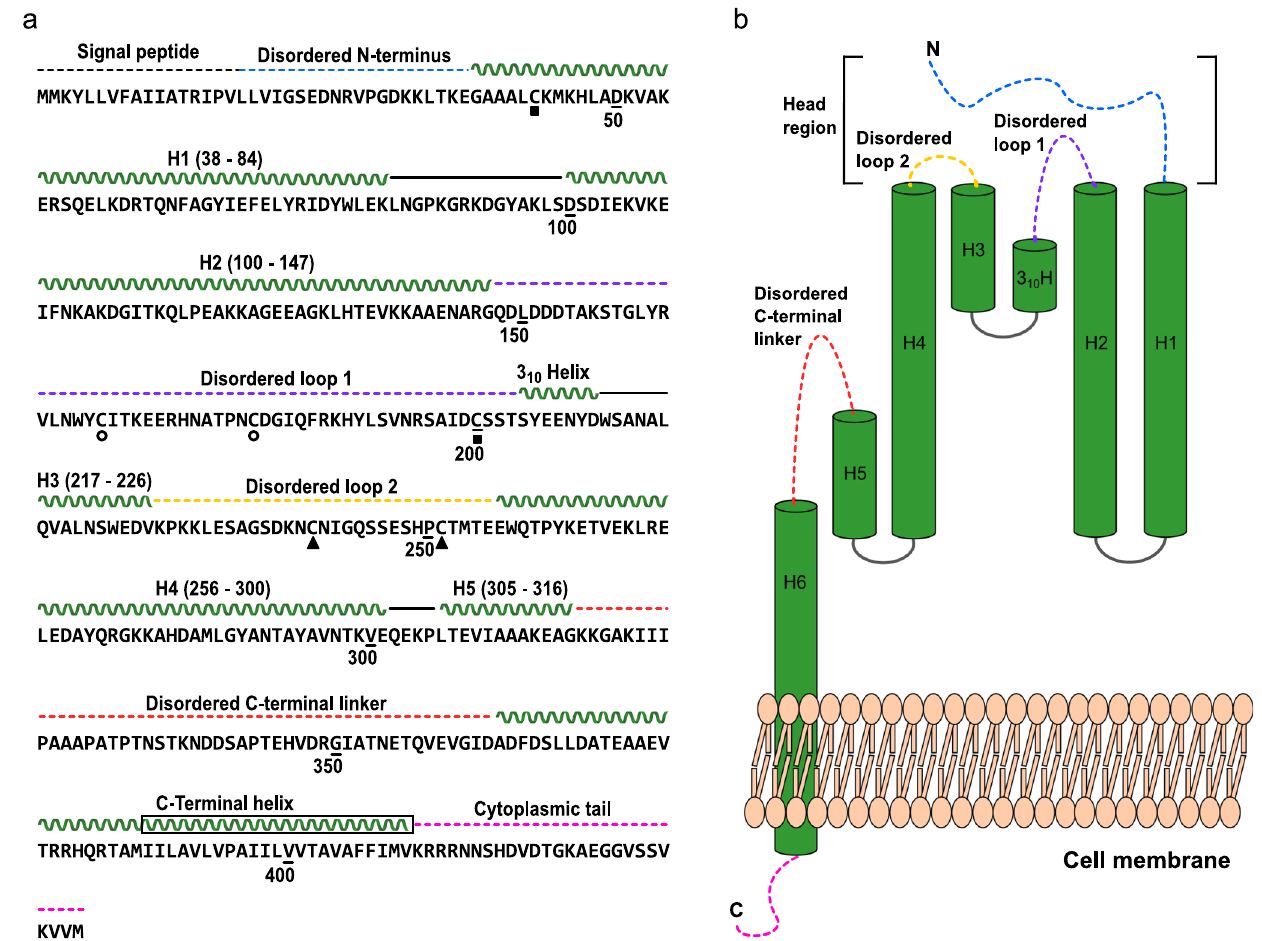
Fig. 8 | Schematic illustration of ISG65 primary and secondary structure. a Amino acid sequence of full-length ISG65. Secondary structure elements are indicatedabovethesequence.Helicesare displayed aswavylines;loops presentin the experimentalmodel are displayedwith solid black lines and loopsabsent from the experimental model are displayed as dashed lines. The colour scheme corre- sponds to panel b . Disulphide-bonded cysteine residues are indicated by squares, circles and triangles, paired residues are marked with the same geometric shape.